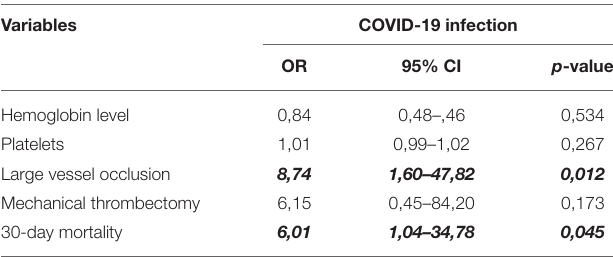
TABLE 3 | Multivariate logistic regression models showing confounders of clinical characteristics of stroke with COVID-19 infection.